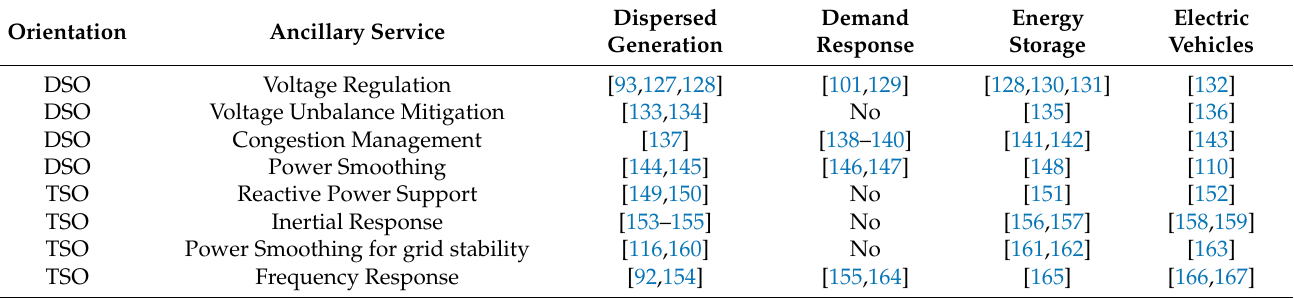
Table 4. Literature review about the applicability of different DER technologies to the specific grid